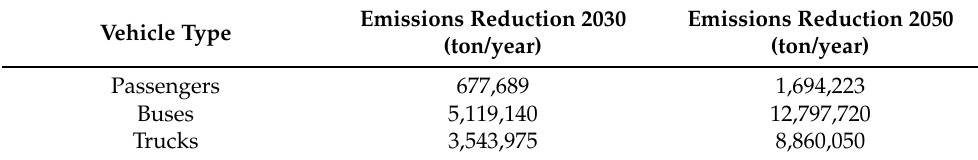
Table 14. CO 2 emissions